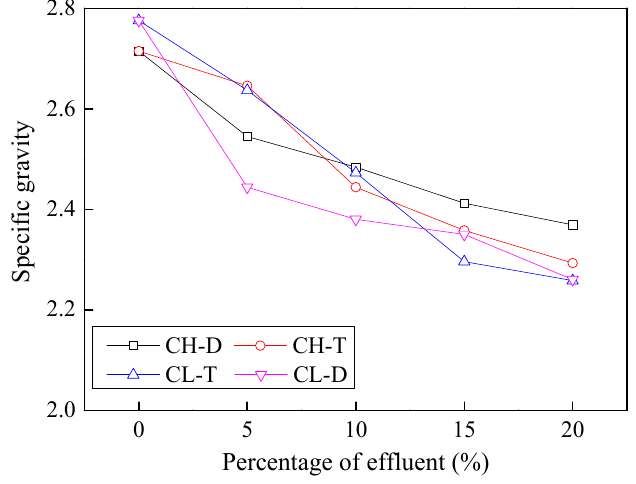
Figure 7. Effects of industrial effluents on specific gravity of cohesive soils.